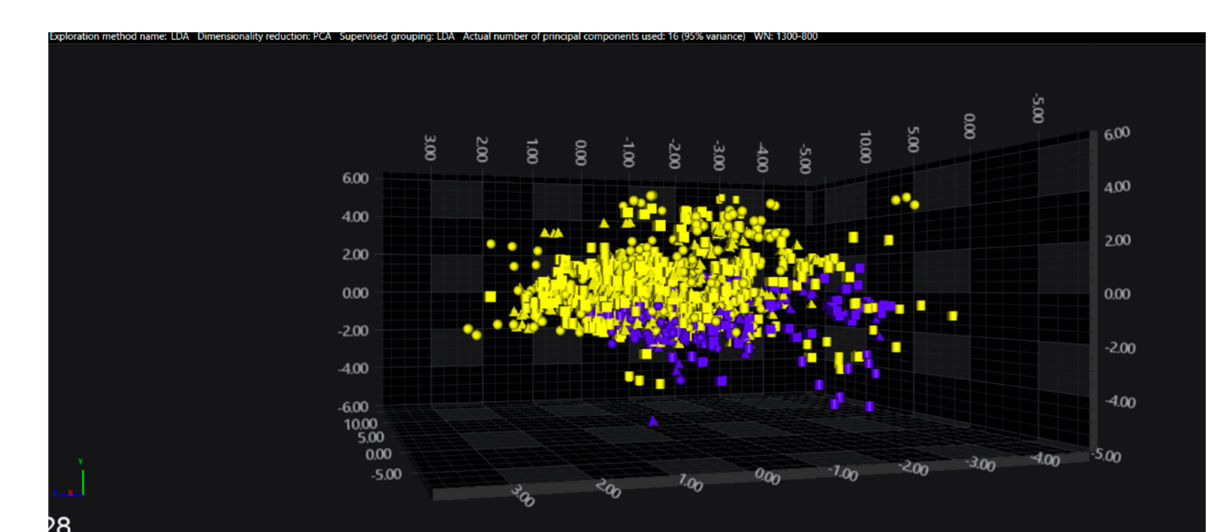
Figure 5. LDA of the O:2 serogroup (blue = Paratyphi A, yellow = other serovars).